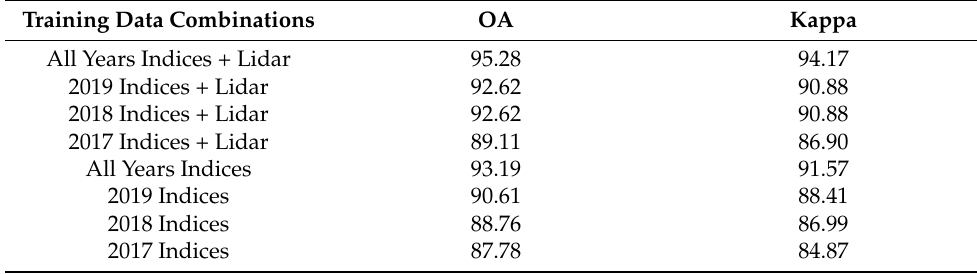
Table 3. Training Data Combination OA and